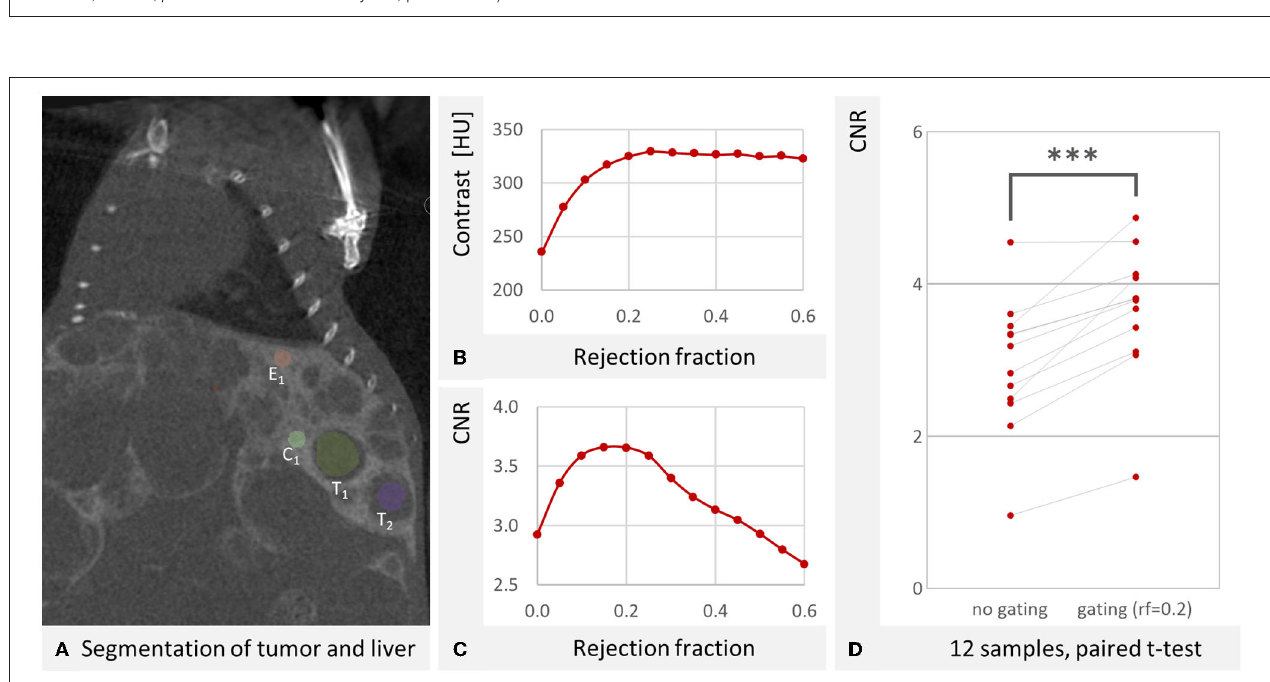
FIGURE 9 | Contrast of liver vs. tumor tissue. (A) An exemplary coronal µ CT slice through the liver. One of the spheres at the liver edge E 1 and one of the spheres at the center C 1 can be seen. The other measurement spheres are in other slices. Also visible is the segmentation of two tumors T 1 and T 2 . The third segmented tumor is not visible in this slice. The artifact at the top of the image is due to the fact that this is also the edge of the volumetric image, where less data is available for reconstruction. W: 4,429 HU L: 670 HU (B) Averaged over all mouse samples, the contrast between liver and tumor increases with RF and reaches saturation at RF = 0.25. (C) Averaged over all mouse samples an optimum contrast to noise ratio of 3.659 was determined at RF = 0.15, similar to 3.657 at RF = 0.2. The noise was derived from a homogenous area of the mouse bed. (D) For the twelve reconstructions, the CNR is significantly ( p < 0.001 as indicated by ***, paired t -test) improved by the gating (RF = 0.2).